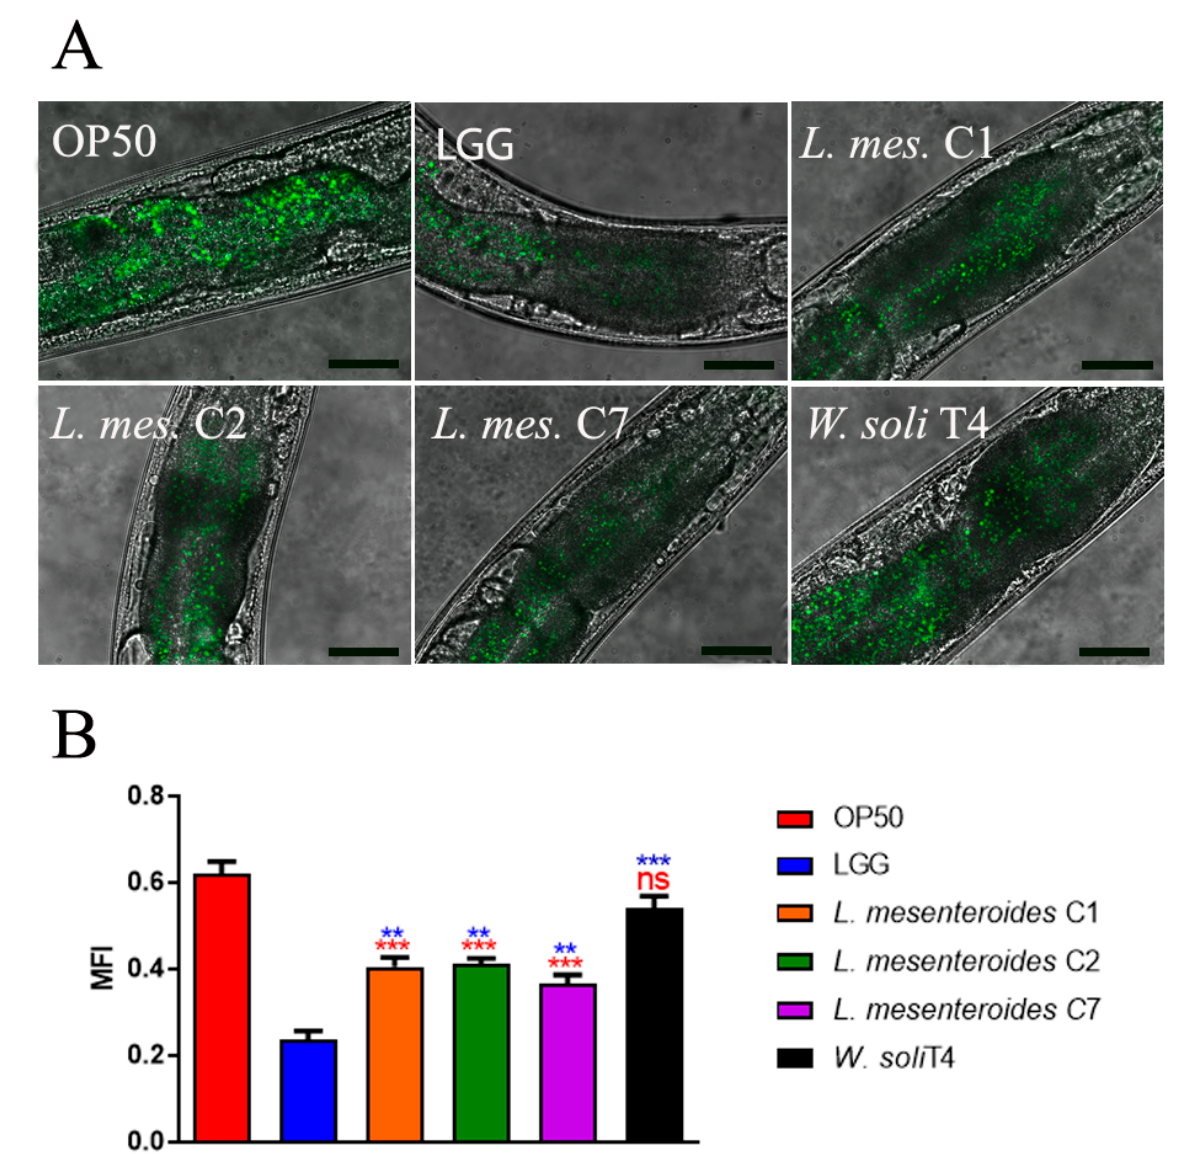
Figure 4. Evaluation of lipofuscin accumulation in C. elegans . ( A ) Autofluorescence of lipofuscin granules in C. elegans fed different LAB on day 10. Ten worms were used for each measurement. LGG- (LAB reference strain) and OP50-fed worms were used as controls. Scale bar = 50 µ m. ( B ) Median fluorescence intensity of nematodes’ lipofuscin. Statistical analysis was evaluated by one-way ANOVA with the Bonferroni post-test. Asterisks indicate significant differences (** p < 0.01, *** p < 0.001) as compared to LGG (blue asterisks) or OP50 (red asterisks) controls, ns: not significant. Bars represent the mean of three independent experiments.